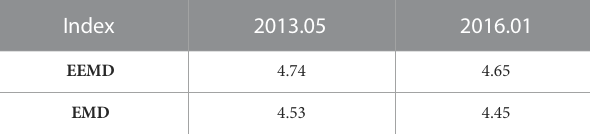
TABLE 1 The RMS_ratio of EMD and EEMD approach for May 2013 and January